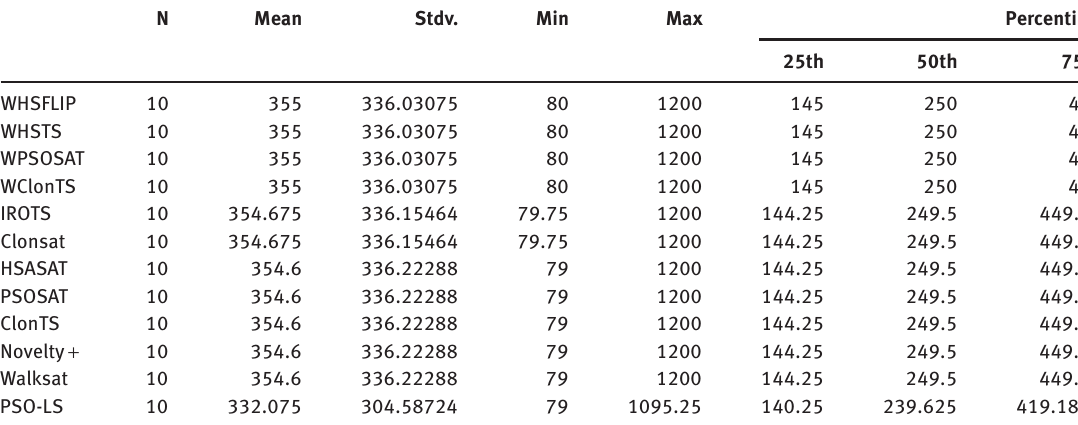
Table 5: Descriptive Statistics.